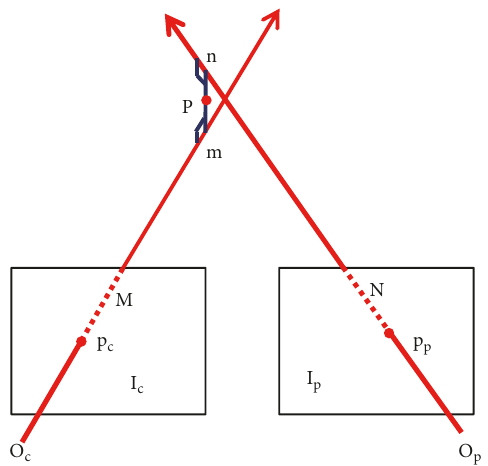
Figure 6: The intersection point of two rays from the pixels in the camera and projector coordinates